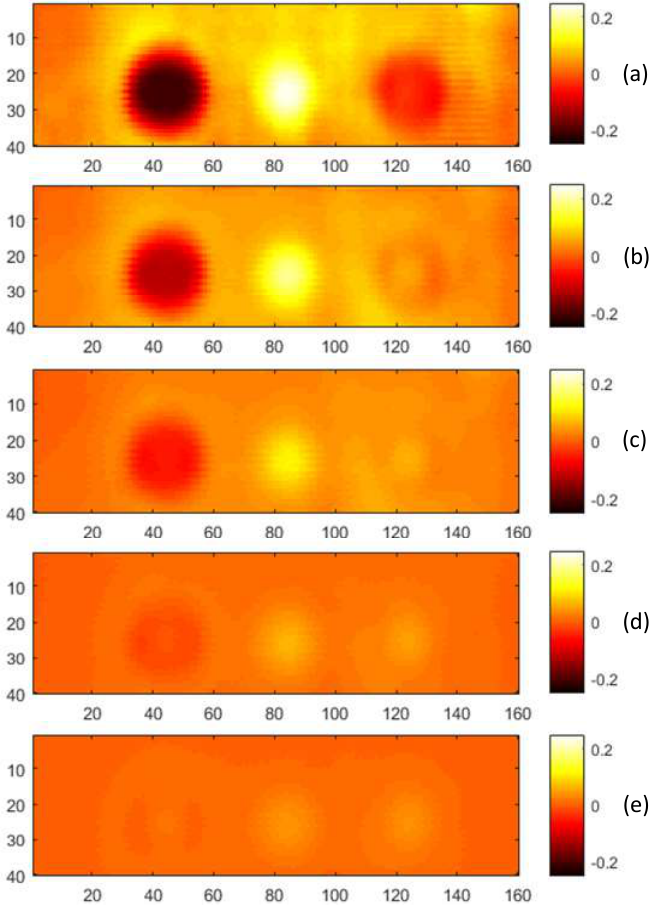
Figure 23. CI scans taken at ( a ) minimal mm lift off, ( b ) 0.5 mm lift-off, ( c ) 1 mm lift-off, ( d ) 1.5 mm lift-off and ( e ) 2 mm lift-off with the aluminium specimen grounded.